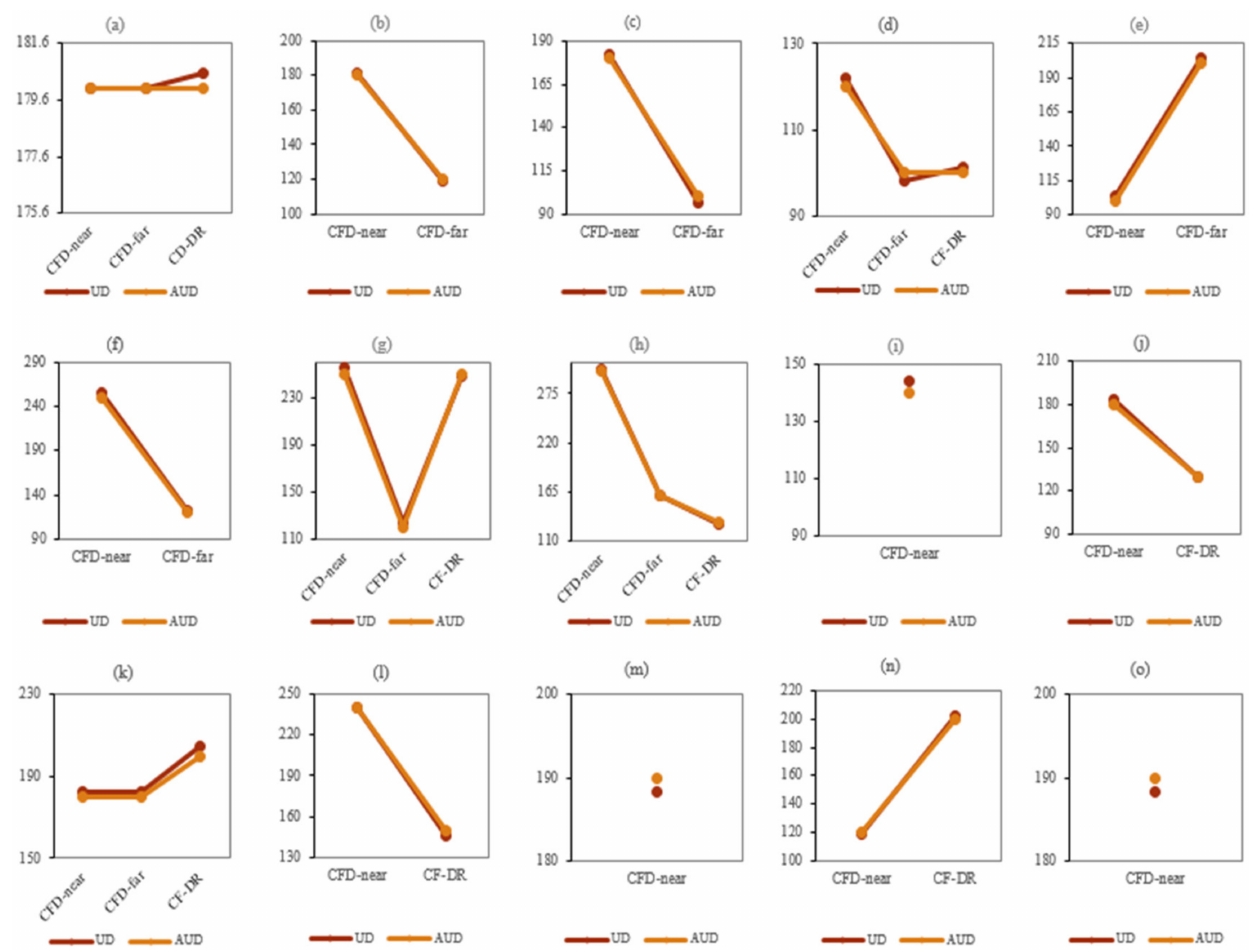
Figure 12. The graphic depiction of DepTSol performance in terms of U D and AU D